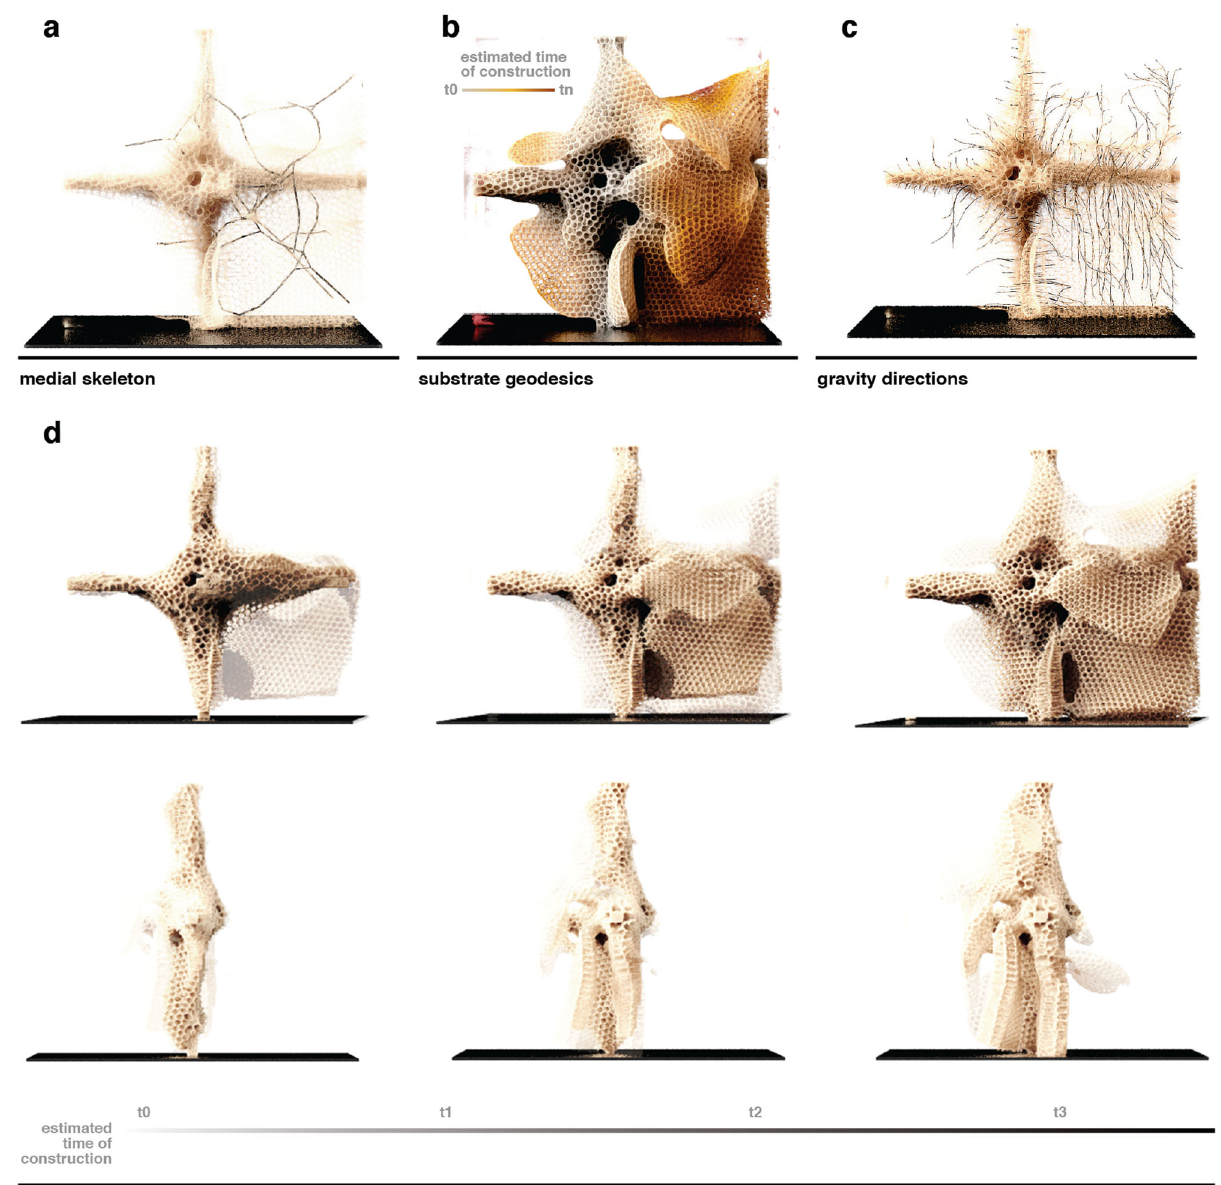
Fig. 6 Simulation of comb construction predicated from geometric measurements. An example prediction of a comb ’ s construction and morphological evolution over time, using geometric data gathered by determining ( a ) the medial axis, ( b ) the geodesic fi eld from the substrate, and ( c ) the gravity vector of each cell. For a given digital comb, we moved back along the direction of gravity and the build direction until a branch in the medial axis was detected. At this branch, we reevaluated the gravity direction and build direction and moved back until another branch was reached, and so on. From these measurements, we can generate a construction timeline ( d ), where the process was run in the reverse direction, showing the morphological changes of the combs over time, guided by the combination of gravity, substrate, and the bees ’ own agency. For each timepoint, the next constructed comb section is depicted with reduced